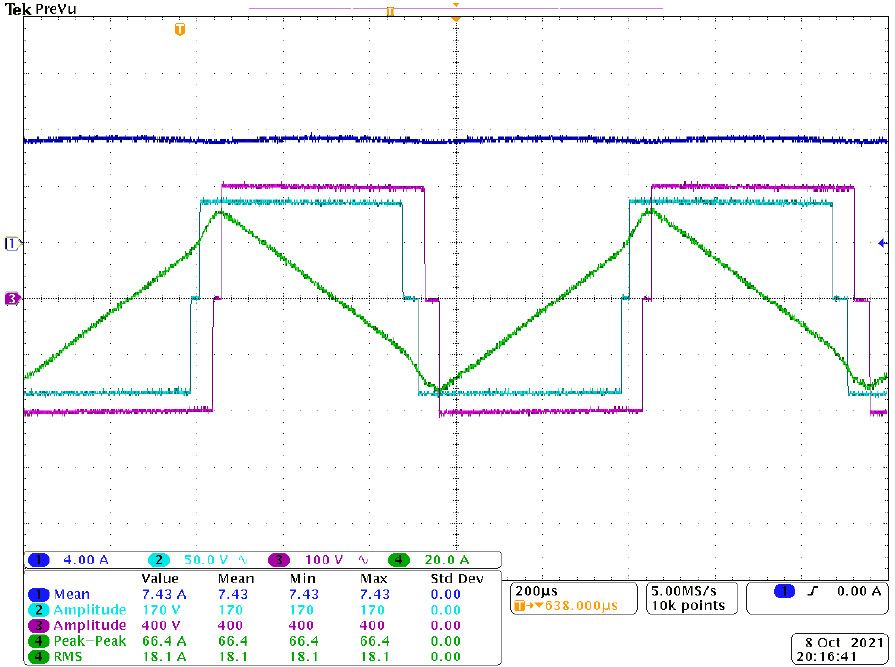
Figure 21. DAB operation at rated power under the DPS-based